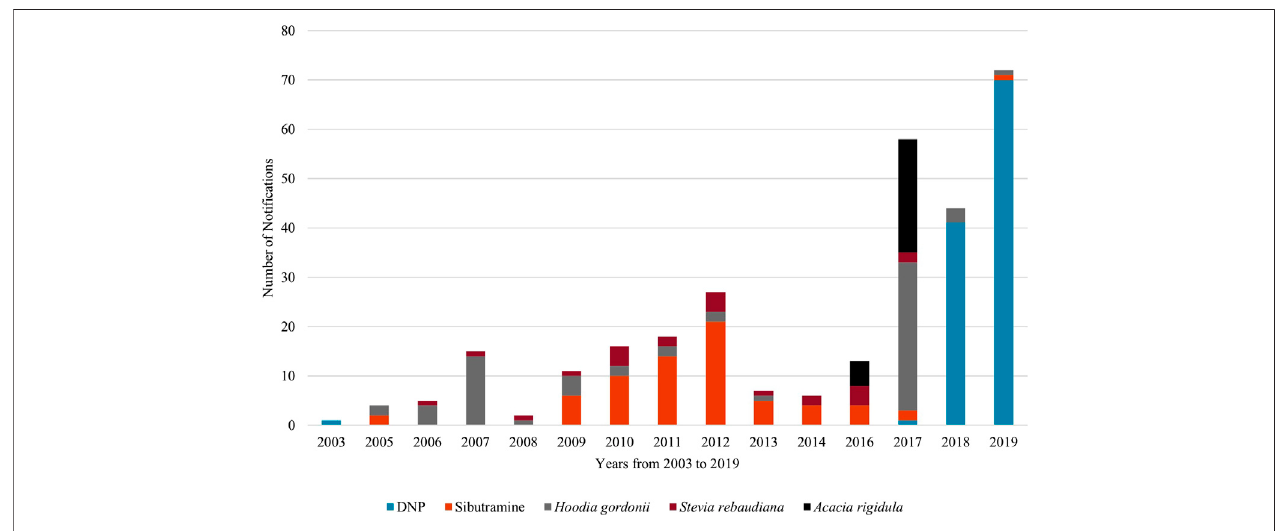
FIGURE 1 | Noti fi cations on weight loss food supplements in the RASFF (2003 –